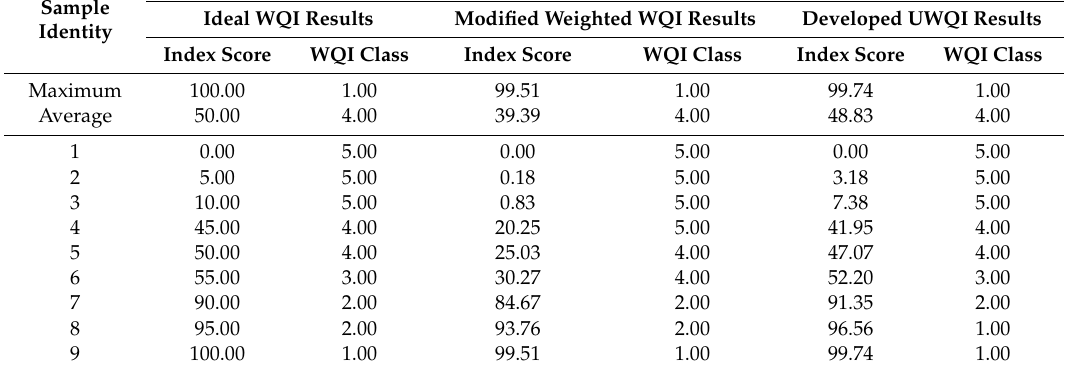
Table 5. Comparison of modified weighted arithmetic water quality index and the developed universal water quality index using scenario-based analysis to establish the functionality and predictive capacity of the models.